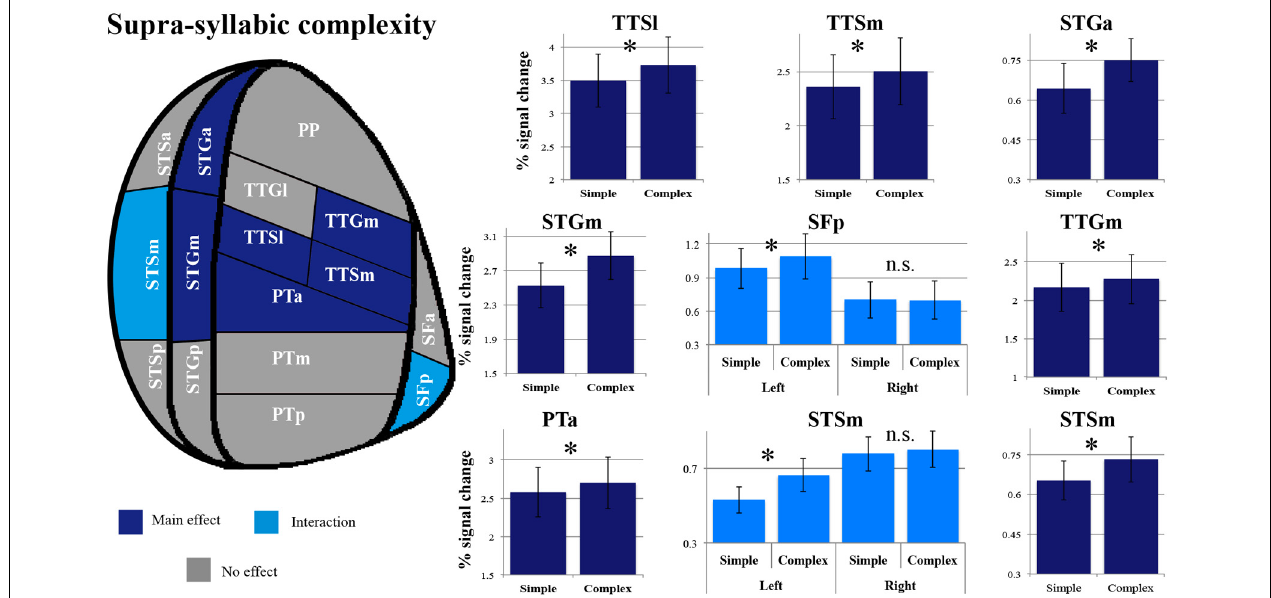
gyrus (m, medial; l, lateral); TTS, transverse temporal sulcus (m, medial, l, lateral); PT, planum temporale (a, anterior; m, middle; p, posterior); SF, caudal Sylvian fissure (a, anterior, p, posterior); STG, superior temporal gyrus (a, anterior, m, middle, p, posterior); STS, superior temporal sulcus (a, anterior, m, middle, p, posterior); ∗ significant contrast at p FWE = 0 . 05, Bonferonni corrected; n.s. non-significant contrast. Error bars represent standard error from the